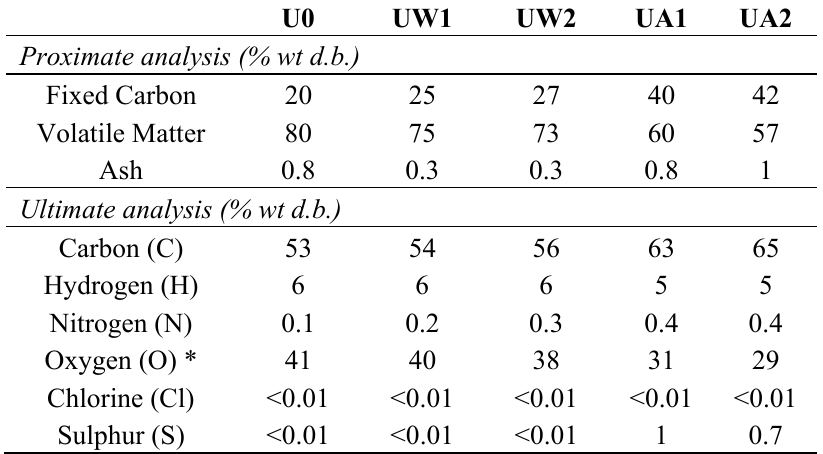
Table 1. Proximate and ultimate analysis of untreated and HTC